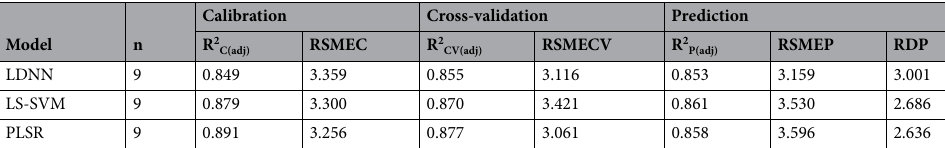
Table 2. Calibration, cross-validation and prediction results of the TVB-N values of rainbow-trout samples by hyperspectral imaging system. R 2 C(adj) adjusted determination coefficient of calibration, R 2 CV (adj) adjusted determination coefficient of cross-validation, R 2 P(adj) adjusted determination coefficient of prediction, RMSEC root-mean-square errors estimated by calibration, RMSECV root-mean-square errors estimated by cross- validation, RMSEP root-mean-square errors estimated by prediction, RDP residual predictive